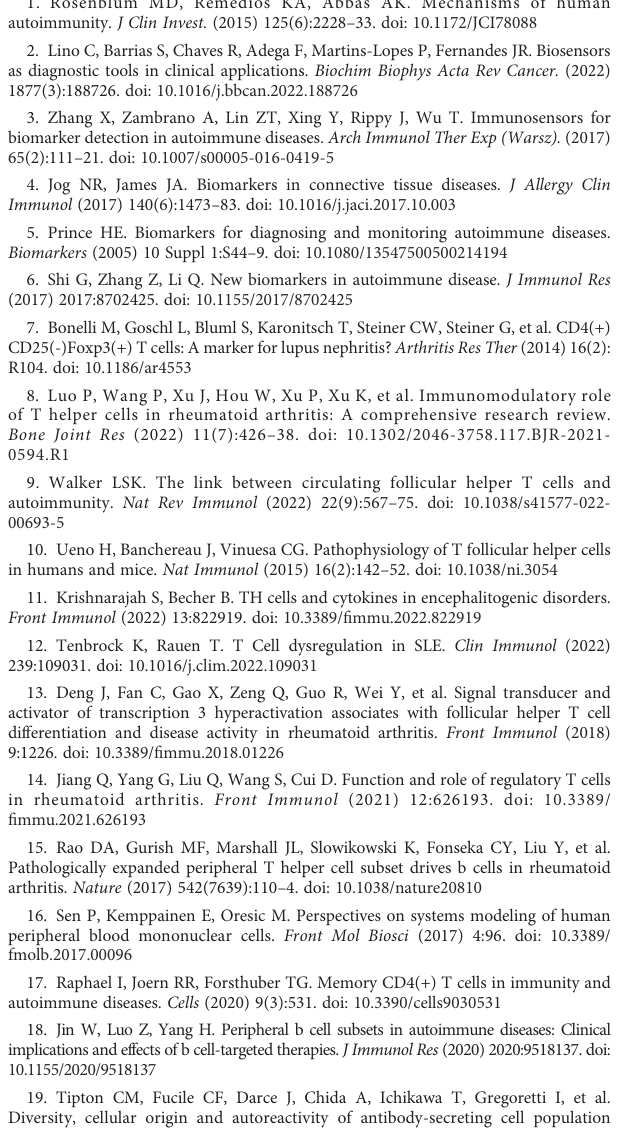
separation of the manually gated subsets. UMAPs were generated in FlowJo. (B) CTLA-4 expression on different T cell compartments. Spectral fl ow cytometry analysis depicting CTLA-4 expression on CD4 + CD25 + , CD4 + CD25 - T cells and Th1 cells in 3 representative healthy controls after 24- hour cultivation without PHA. (C, D) Summary bar diagrams depicting the percentages of indicated (C) PBMC and (D) T cell subsets, respectively, activated for 24 hours in the presence of drug 1-5 or DMSO as control. Bar charts show percentages within (C) viable PBMCs or (D) CD3 + T cells (for CD4 + and CD8 + T cells) and CD4 + T cells (for Th1, Th2, Th17, Tfh, Tph and Treg), respectively. Statistical comparisons were done by one-sample t-test, comparing the 6 individual replicates of every condition to DMSO. Signi fi cance was de fi ned as p-value (* P < 0.05, ** P < 0.01, and *** P < 0.001). (D) The DC subset encompasses pDCs and mDCs. Abbreviations are used as follows: dendritic cells (DC), monocytes (Mo), natural killer cells (NKs), B cells (Bc), T cells (Tc), naïve T cells (TN), central memory T cells (TCM), terminally differentiated effector T cells (TEMRA), effector memory T cells (TEM), T helper cells (Th), regulatory T cells (Treg), T follicular helper cells (Tfh), T peripheral helper cells (Tph).